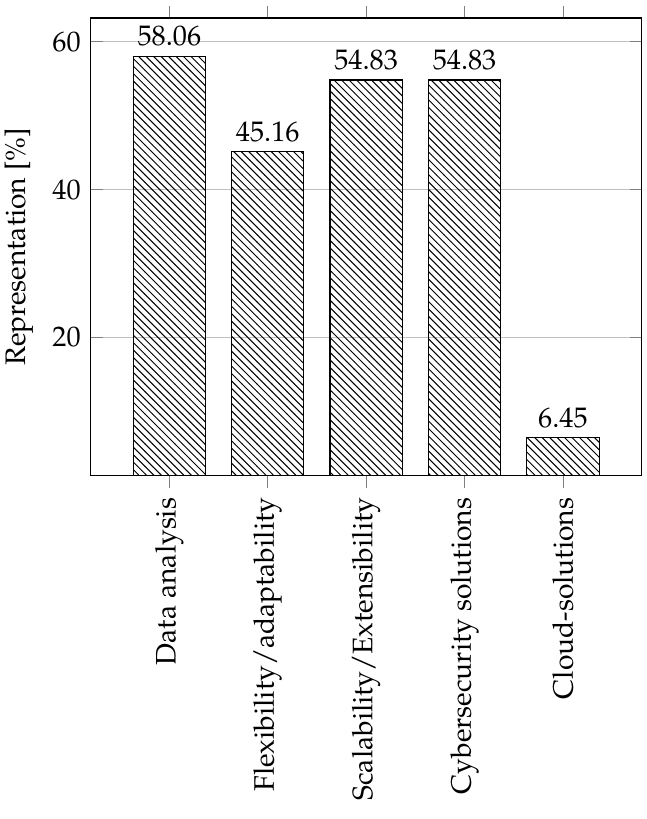
Figure 21. The percentage of selected testbeds’